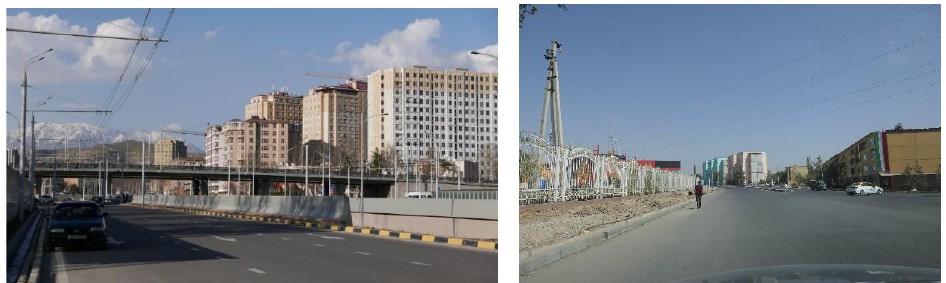
Figure 2. Aerial photographic plates of Dushanbe (courtesy of the Young Generation of Tajikistan).